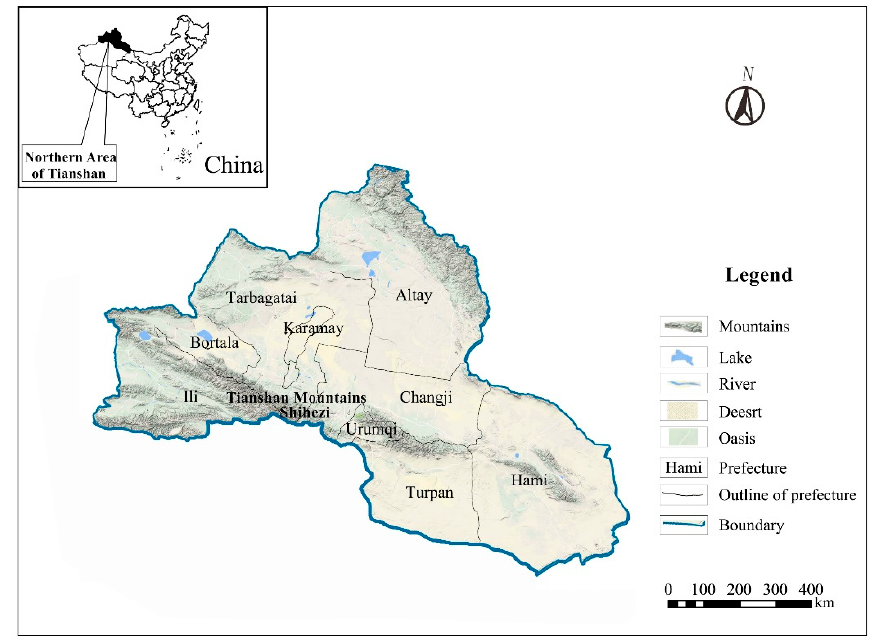
Figure 1. Geographical location map of the northern Tianshan Mountains (NTM) region.